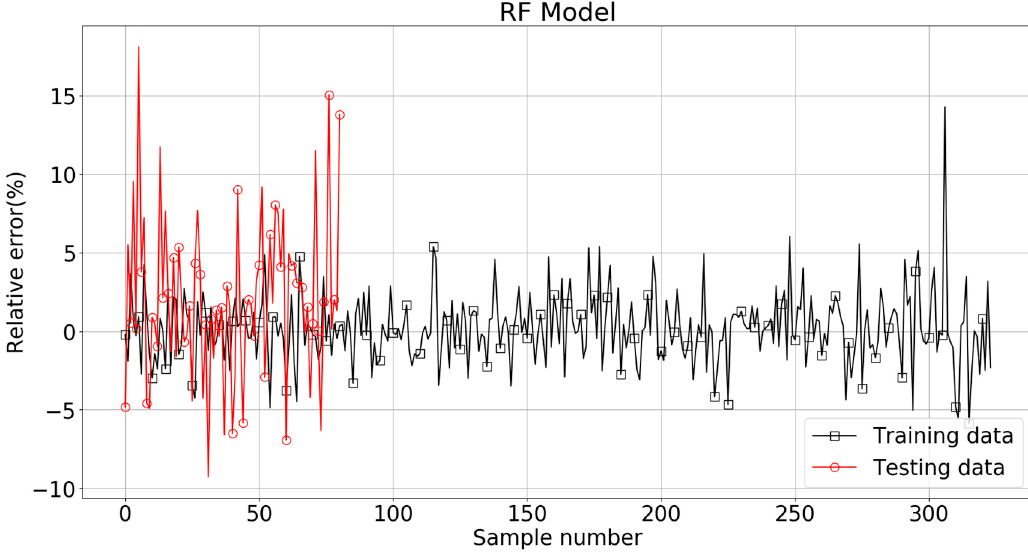
Figure 21. Variation of the relative errors obtained from the RF model.